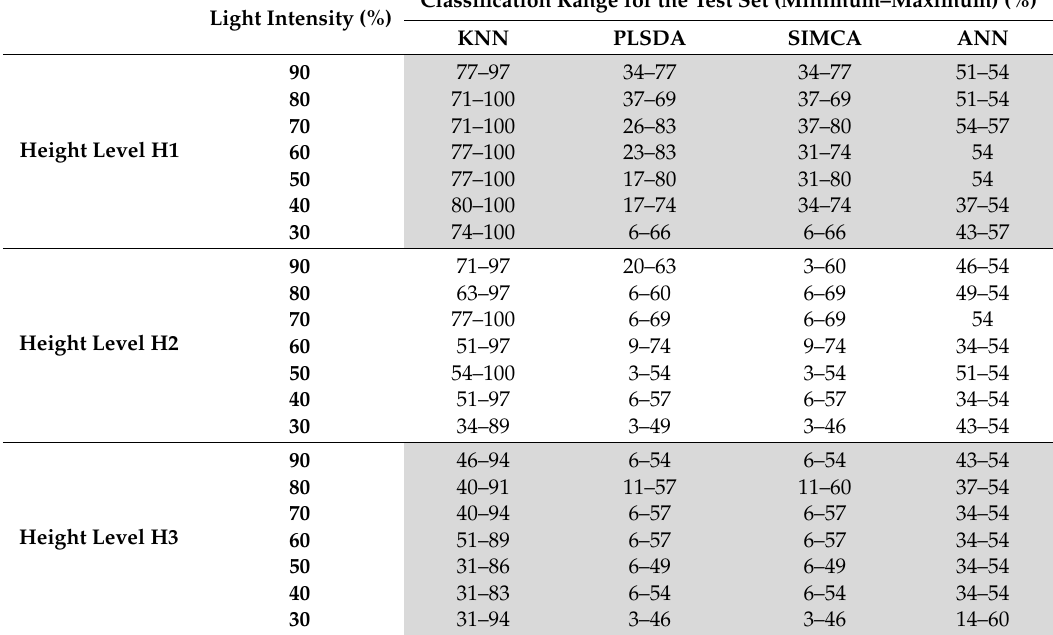
Table 3. Classification prediction accuracy for flour and powder samples at di ff erent sensor heights and light intensities using di ff erent pre-processing methods on the recorded